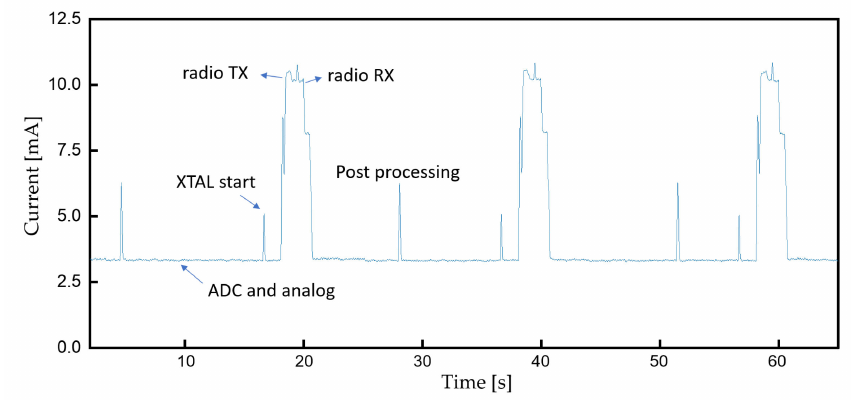
Figure 17. Current consumption during continuous